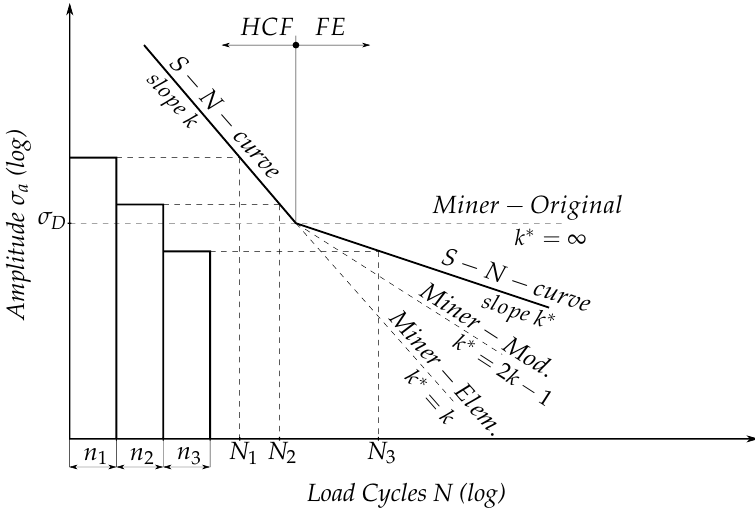
Figure 13. Palmgren–Miner Rule. Adapted from